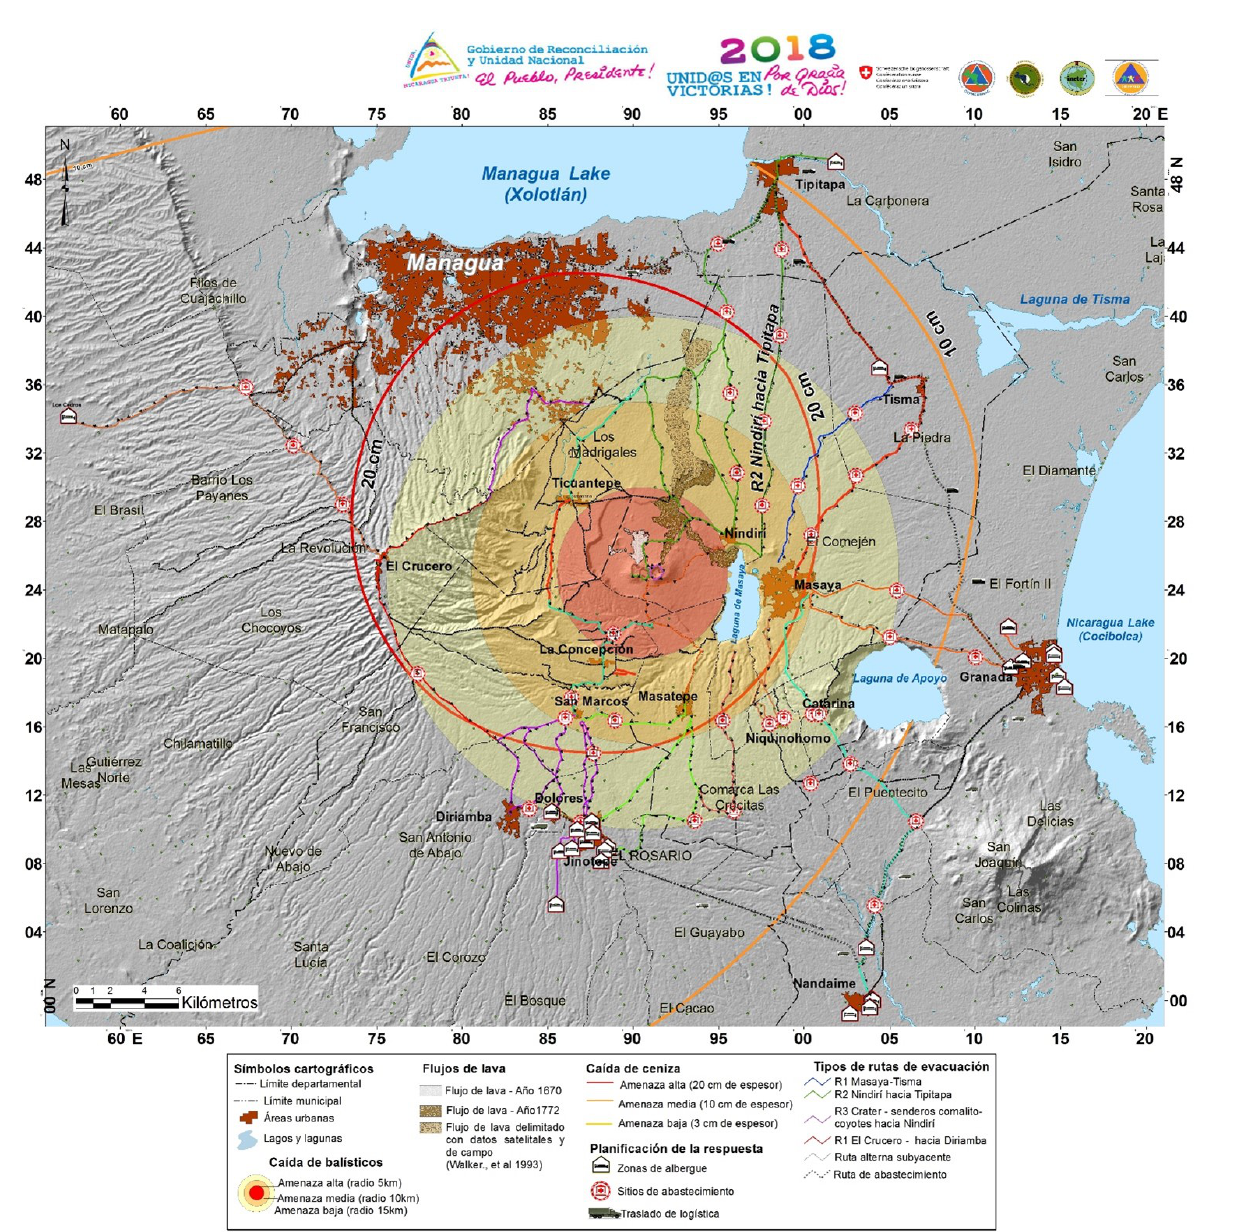
Figure 3: Map of multiple hazards at Masaya volcano: ballistic impacts, tephra fall, lava flows, and evacuation routes are shown (blue, green and purple